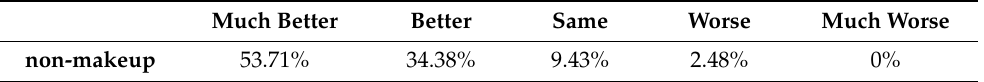
Table 7. Quantitative comparisons between non-makeup and ours.